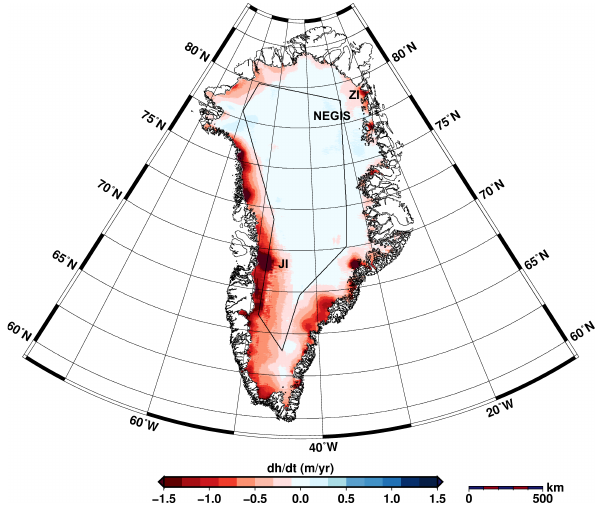
Figure 11. Map of elevation change of Greenland between Jan- uary 2011 and January 2014 derived from along-track processing of three full CryoSat-2 cycles. The black polygon indicates the mode mask of CryoSat-2. Inside the polygon LRM and outside SARIn data were acquired. NEGIS: Northeast Greenland Ice Stream, JI: Jakobshavn Isbræ, ZI: Zacharias Isstrømen same order as presented previously (Pritchard et al.,